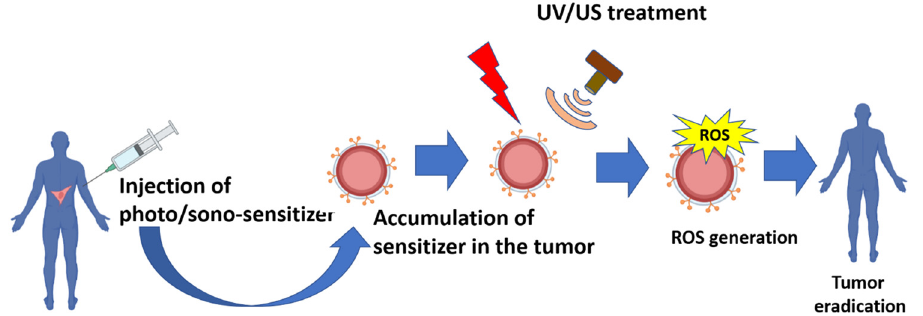
Figure 11: The schematic view of PDT and radio therapy ( SDT ) .